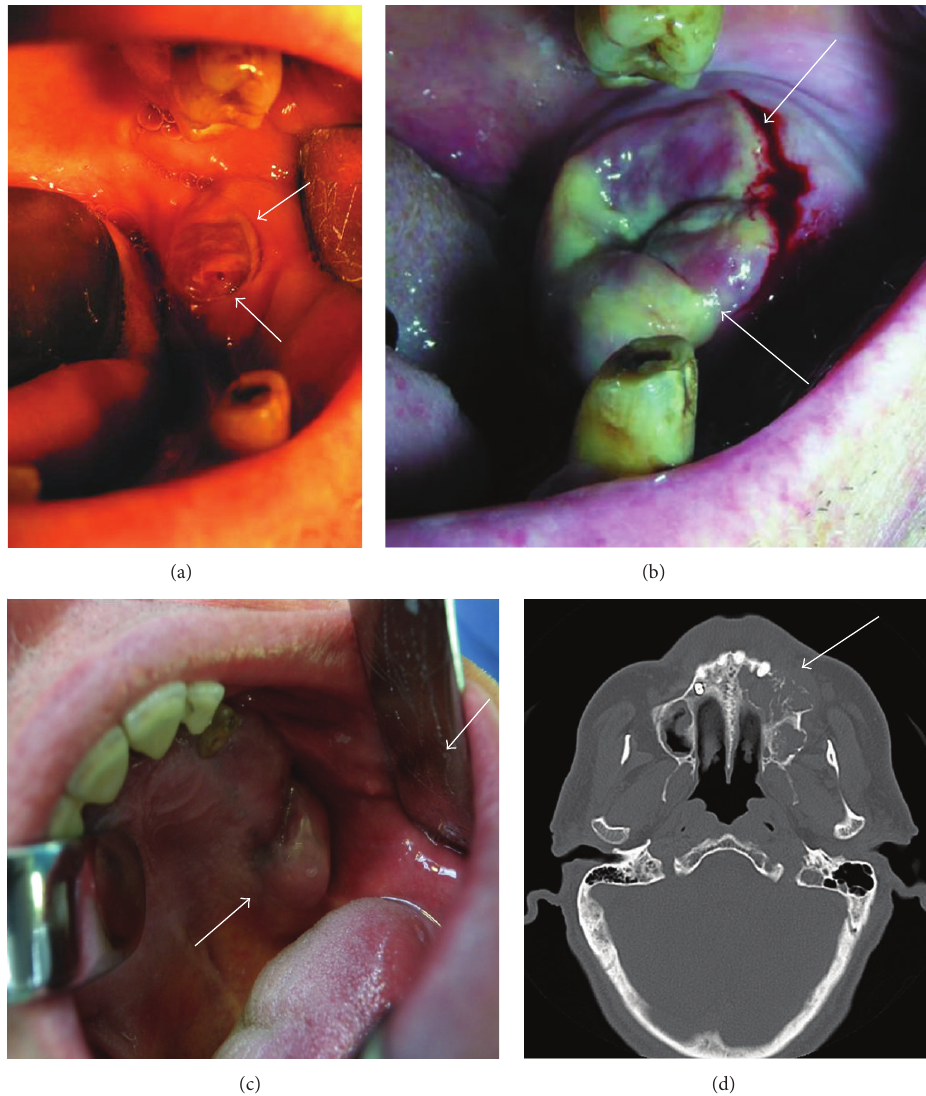
Figure 1: Extramedullary plasmacytoma, macroscopic features. (a) The soft mass neoplasm appears pink in colour and has floating consistency with a diameter of about 1.5 cm, occupying the area of dental elements 37 and 38. It has ill-defined contours and is slightly ulcerated on the top for the effects of antagonist dental elements, causing algia and difficulty in chewing for the patient. No sign of bone involvement at the orthopantomography (Case A). (b) The patient presented a relapse of the neoplasm seven days after the biopsy, with the enlargement of the lesion to the entire edentulous left side of the jaw, until the first premolar. The mucosa covering the lesion was of irregular colour and the traumatism due to the antagonist dental elements was accentuated (Case A). (c) The mass presented as a swelling in the left posterior region of the maxilla, with maximum dimensions 25 × 45 mm, involving also palate and gingiva. The mass consistency was hard elastic and normal in colour and covered with intact oral mucosa (Case B). (d) The maxillofacial CT scan showed an important osteolytic involvement of the upper alveolar process and the partial obliteration of the basal portion of the left maxillary sinus. The lesion extended also to the homolateral nasal cavity. Concomitant enlargement of lateral cervical and submandibular lymph nodes, with the biggest having 13mm diameter (Case